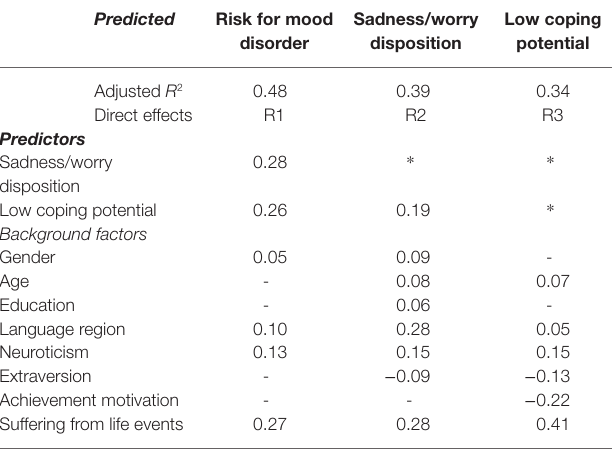
TABLE 2 | Summary of the results of the hierarchical regression analyses (stepwise entry) according to the theoretical ordering (in regression steps R1–R3) shown in Figure 1 (listing adjusted R 2 and beta coefficients).